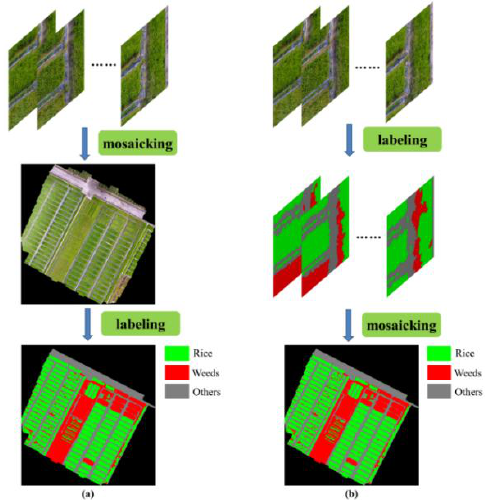
Figure 3. Two workflows to produce the weed cover map for the whole field. ( a ) The workflow of mosaicking-labeling; ( b ) the workflow of labeling-mosaicking.